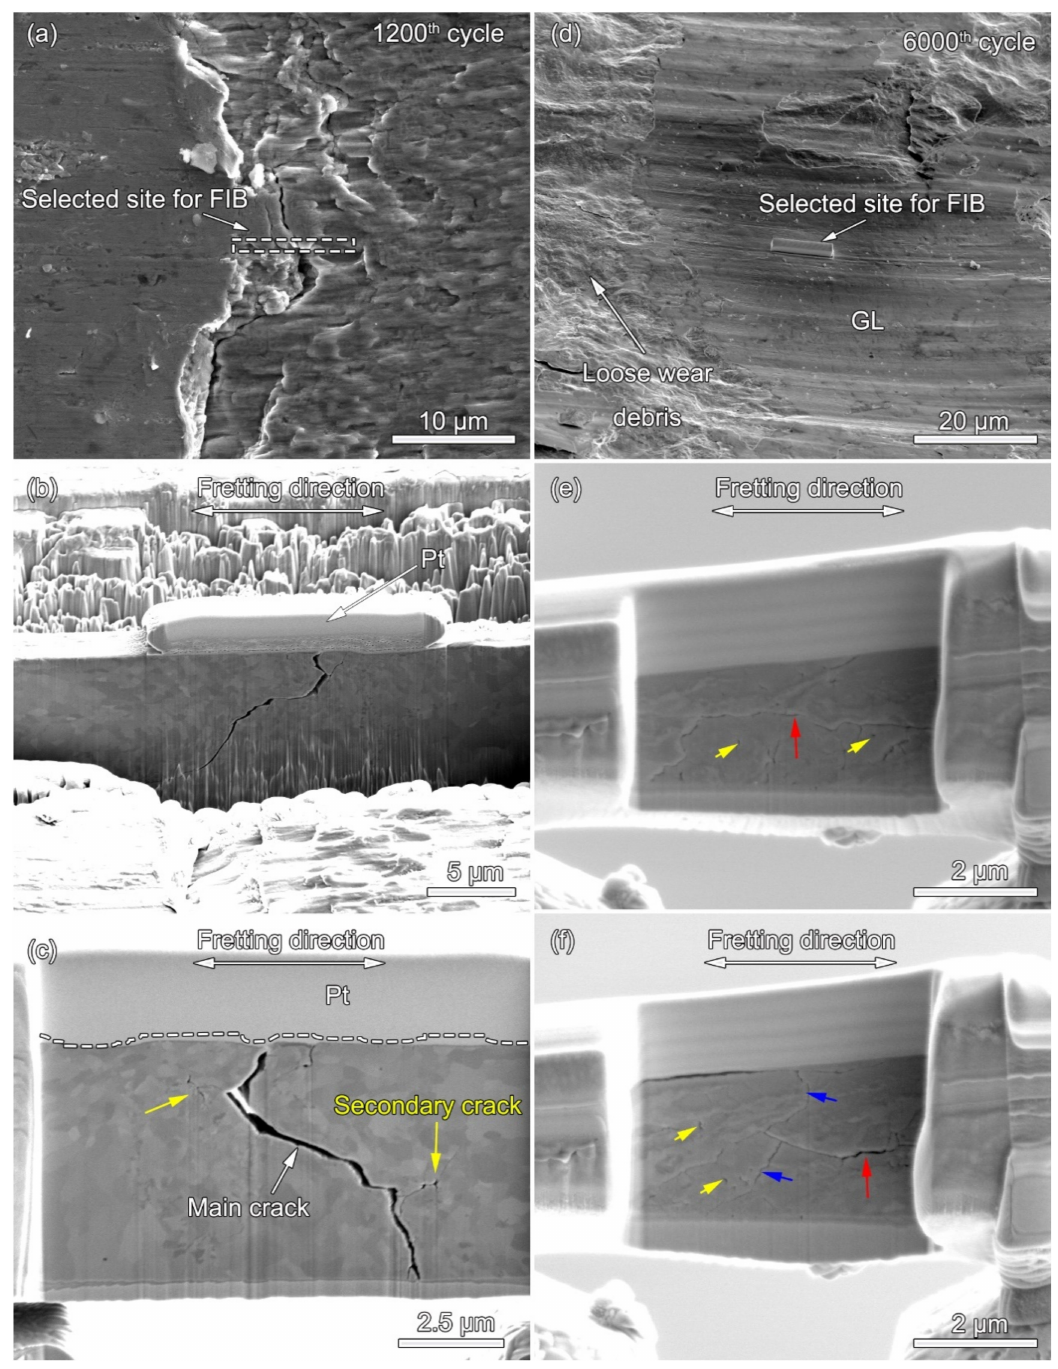
Figure 9. The SEM images during the FIB process: ( a ) The magnified image of the wear scar at the 1200th cycle. ( b ) The isolated membrane during the FIB process with a deposited Pt layer to protect the surface feature. ( c ) The cross-section after the final polishing. ( d ) The magnified image of the wear scar at the 6000th cycle. The cross-section after ( e ) 45 min and ( f ) 90 min of